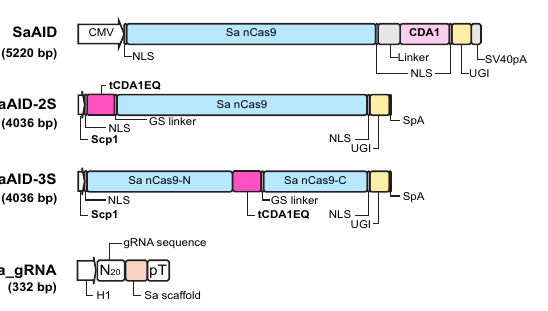
target sites were edited by plasmid DNA vector transfection and ana- lyzed by amplicon deep sequencing. Editing ef fi ciency of cytosine at each nucleotide position relative to the PAM sequence is shown in Supplementary Fig. S6 and averaged in Fig. 2a. Target-AID was capable toperform>20%ofeditingtoallsites.AID-2S,AID-3S,YE1,andYE2also